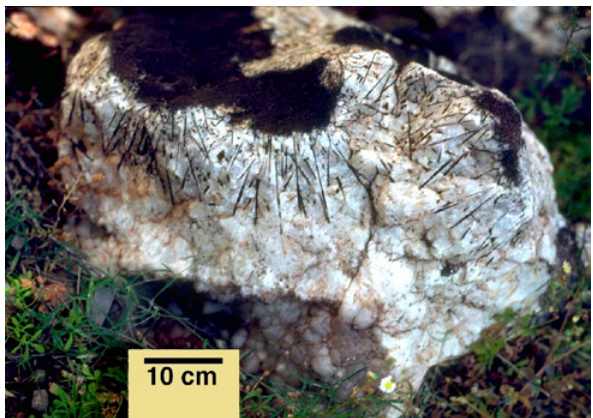
Figure 83. Catalytic crystal growth enhancement sometimes occurs on two faces of the original seed crystal resulting in growth of a bladed or platy crystal form. This magnetite in quartz from Peko Mine in Tennant Creek has probably grown from dispersed lepi- docrocite to developed this bladed form instead of the more usual compact octahedra.